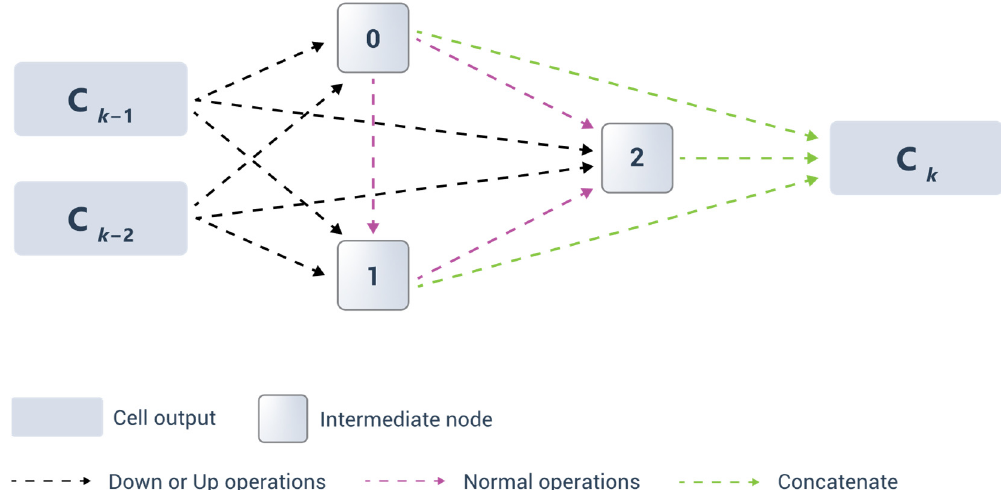
Figure 3. A directed acyclic graph diagram for cell architecture with three intermediate nodes (0, 1, 2). The black arrow demonstrates a down operation, the magenta arrow depicts the normal operation (an operation that does not reduce the dimension of the feature map), and the green arrow illustrates a concatenate operation.